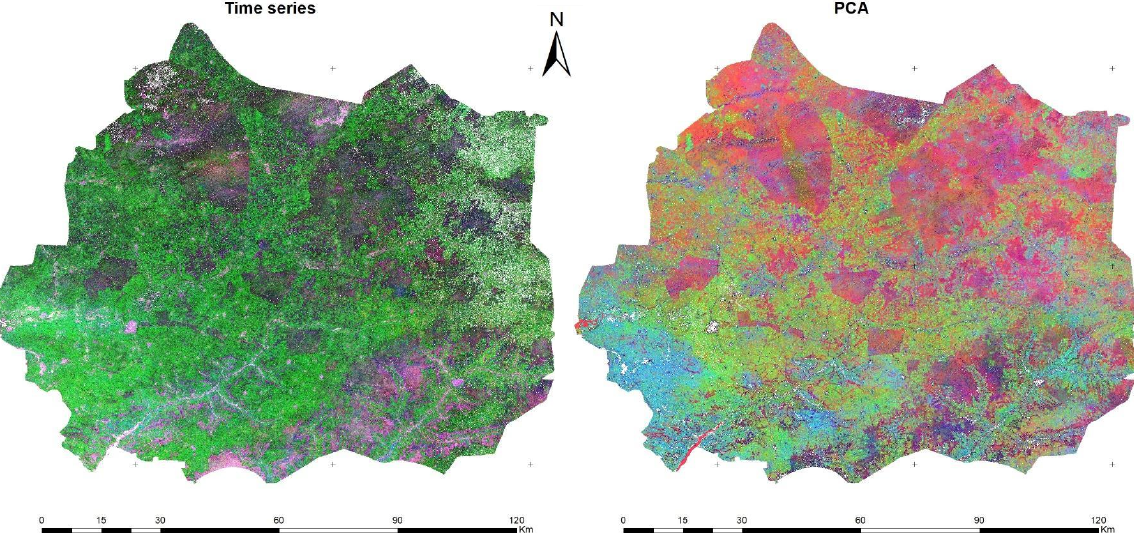
Figure 5. Multitemporal composite of S-1 data (RGB:June/October/January) and color composite of PCA (RGB:PC1/PC2/PC3) over the Kaffrine region.